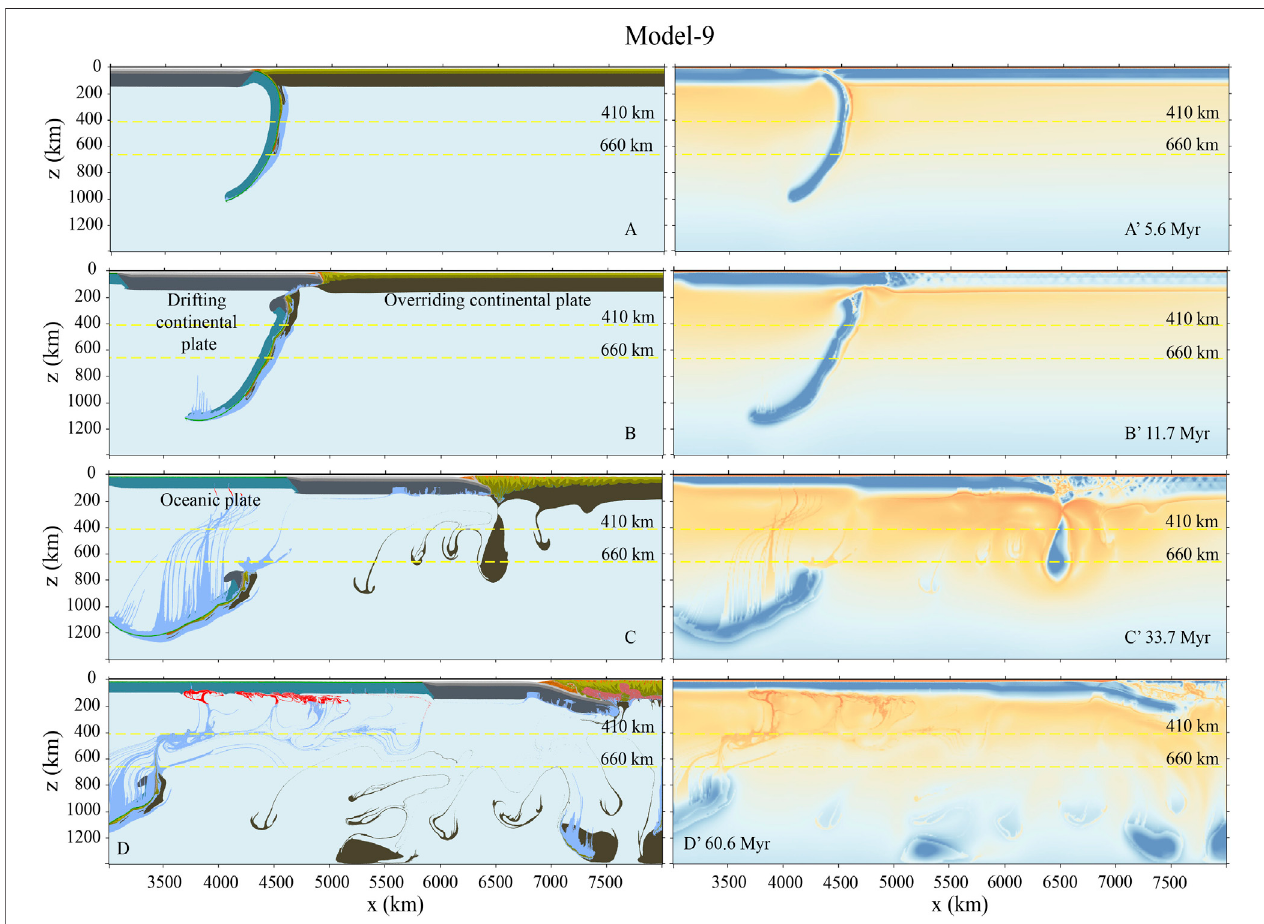
FIGURE 11 | Model-9 evolution with a further decreased and uniform plastic friction coef fi cient of the overriding lithospheric mantle of λ · sin ( φ ) (cid:2) 0.01 ( SupplementaryTableS2 and SupplementaryEquationS11 inthesupportinginformation).Alltheotherparameters areidenticaltoModel-8( Figure10 ). (A – D) The composition fi eld evolution with the corresponding colorbar is shown in Figure 2A . (A ’ – D ’ ) The effective viscosity evolution with the corresponding colorbar is shown in Figure 2B .